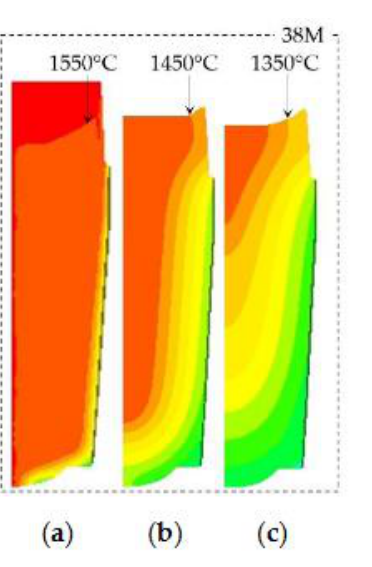
Figure 7. Temperature fields predicted by 38 M and 22 M at times of: ( a , d ) end of filling; ( b , e ) 5.5 h; ( c , f ) 10.5 h.